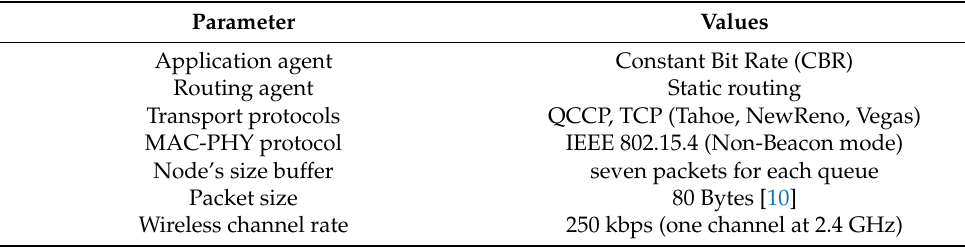
Table 4. Setting parameters for network and